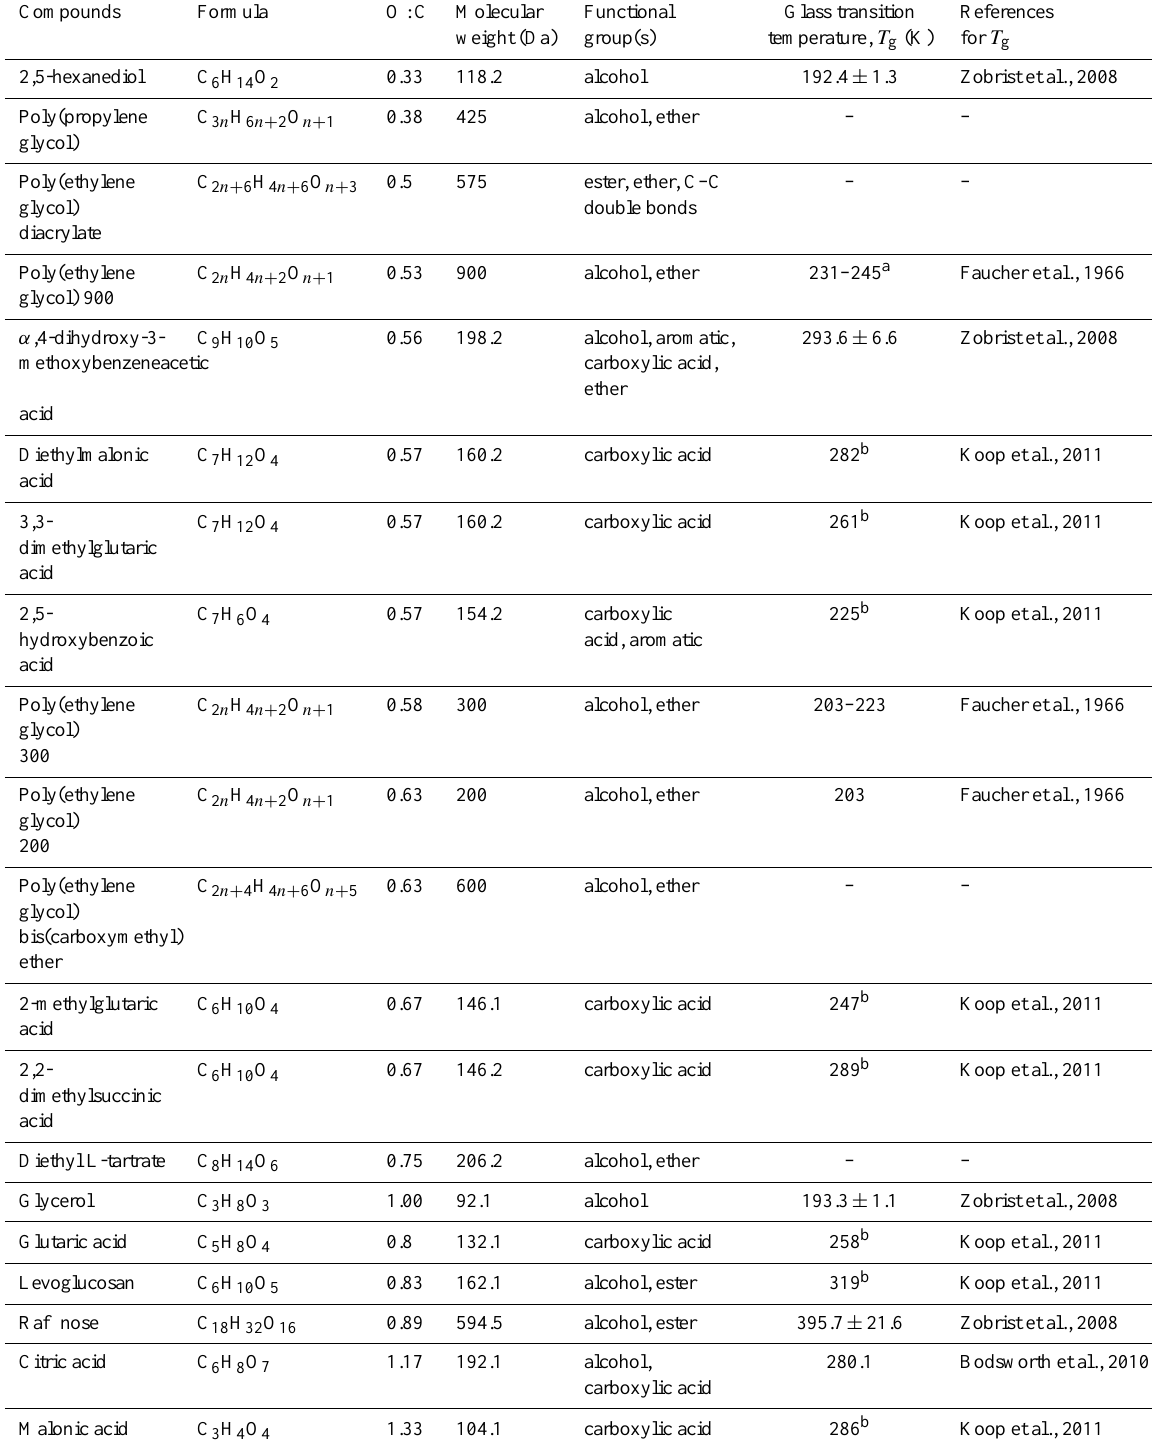
Table 2. Summary of the 20 organic species used in temperature-dependent experiments. Each organic species was separately mixed with am- monium sulfate to make particles, and liquid–liquid phase separation was studied in these particles at 244 ± 1K, 263 ± 1K, and 278 ± 1K. Two of the organic species (poly(ethylene glycol) diacrylate and raffinose) mixed with ammonium sulfate were also studied at 290 ±